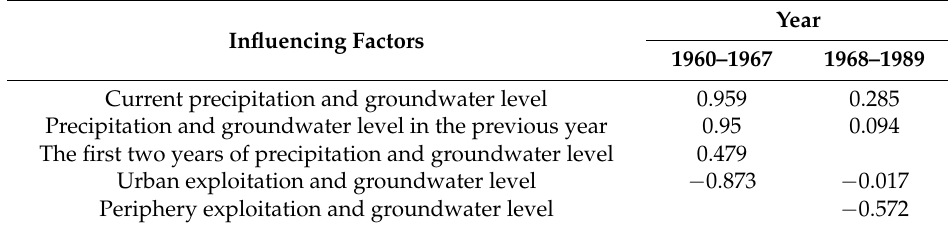
Table 2. Partial correlation coefficients between various factors and groundwater levels.